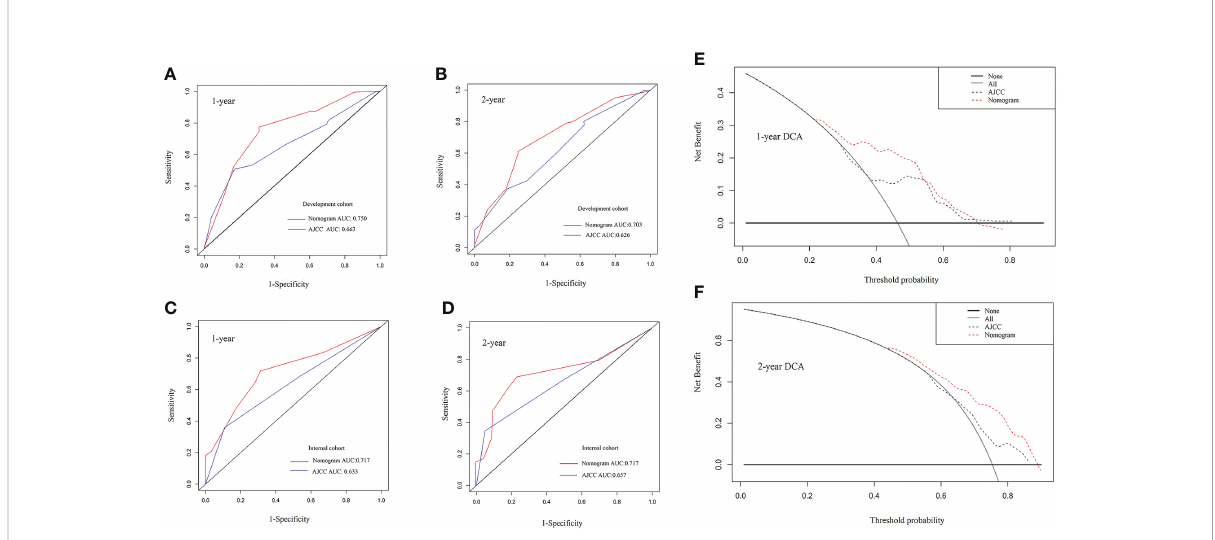
FIGURE 2 (A – D) The 1-year and 2-year receiver-operating characteristic (ROC) curve of the development group and the internal veri fi cation group for the nomogram and AJCC TNM (8 th ) staging system of patients with pancreatic adenosquamous carcinoma. (A) 1-year development group (B) 2-